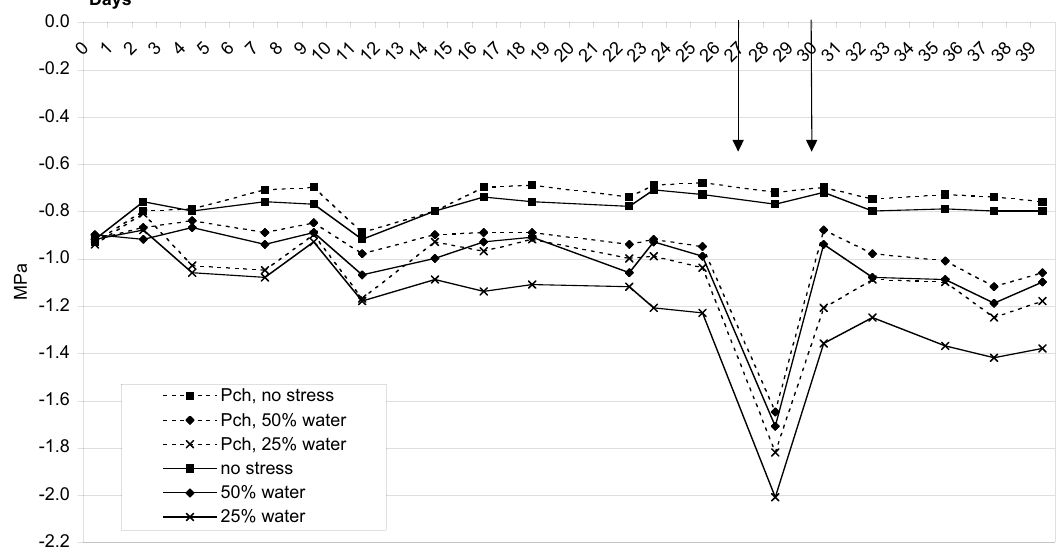
Fig. 6. Effect of water stress on leaf water potential of infected and uninfected Chardonnay, March 2006.